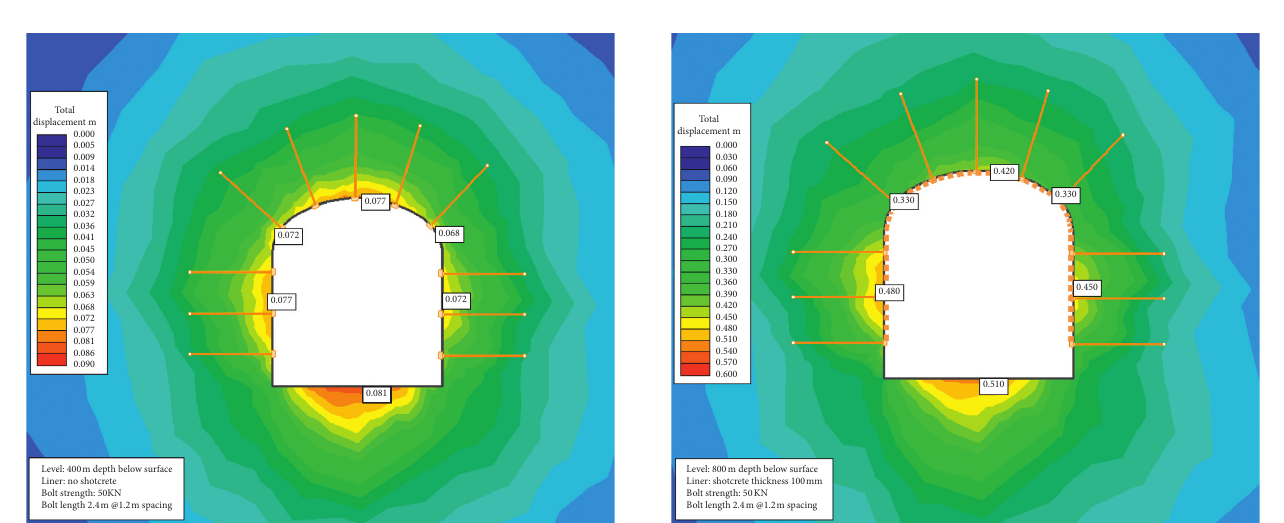
Figure 7: Displacement of scheme 9.